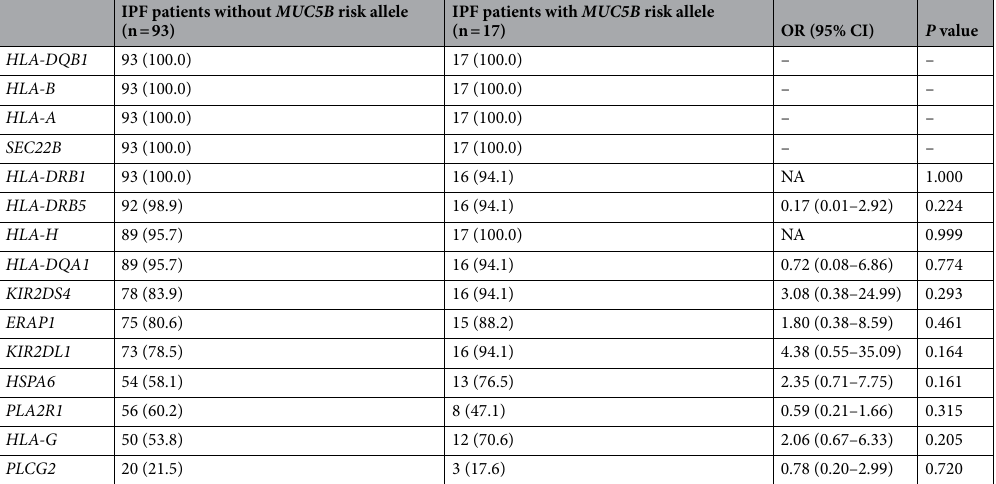
Table 4. Associations between MUC5B risk allele and mutated genes involved in the immunity pathway. IPF = idiopathic pulmonary fibrosis. All values are reported as number and percentage. The value represented the number of the patients with rare variants in each gene. P values and odd ratio (OR) with 95% confidence intervals (CIs) were from logistic regression